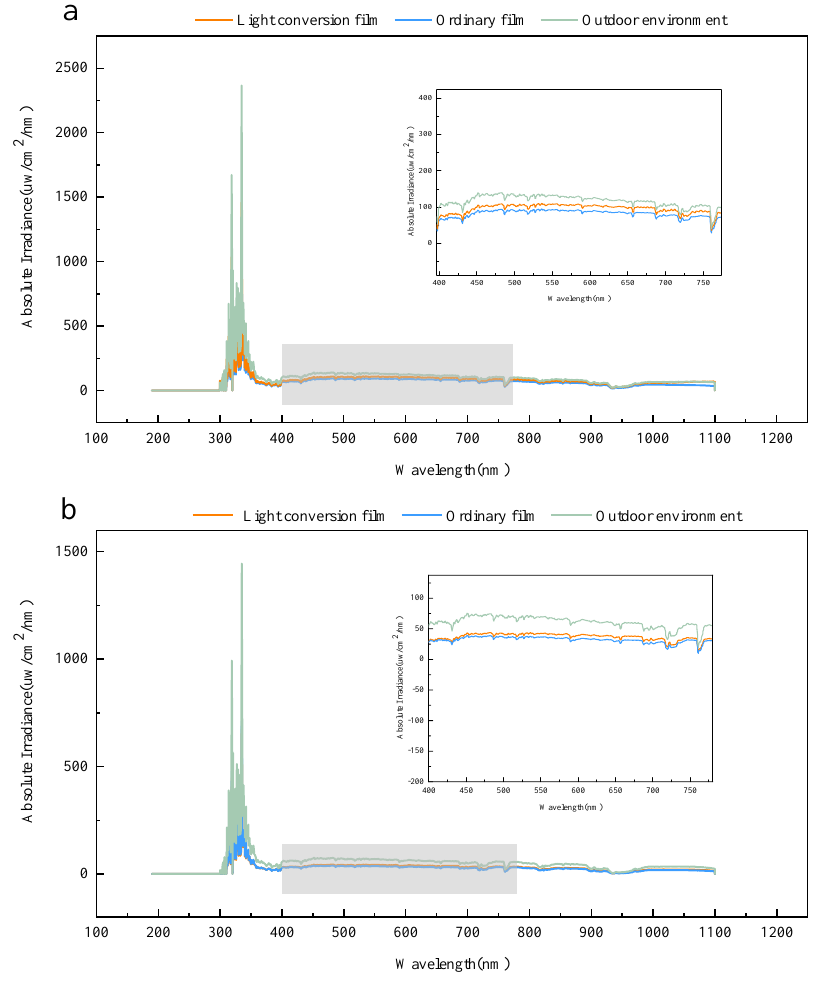
Figure 3. Irradiance analysis of light conversion film and ordinary film ( a ) Indicates the comparative analysis of irradiance between light conversion film and ordinary film under sunny days; ( b ) Indicates the comparative analysis of irradiance between light conversion film and ordinary film under cloudy weather.